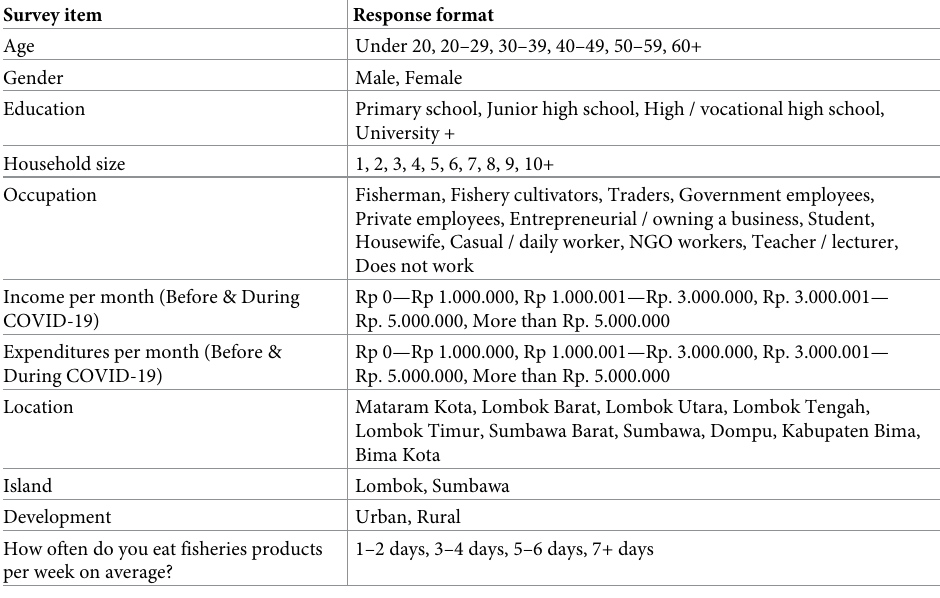
Table 1. Demographic and socio-economic survey items and response